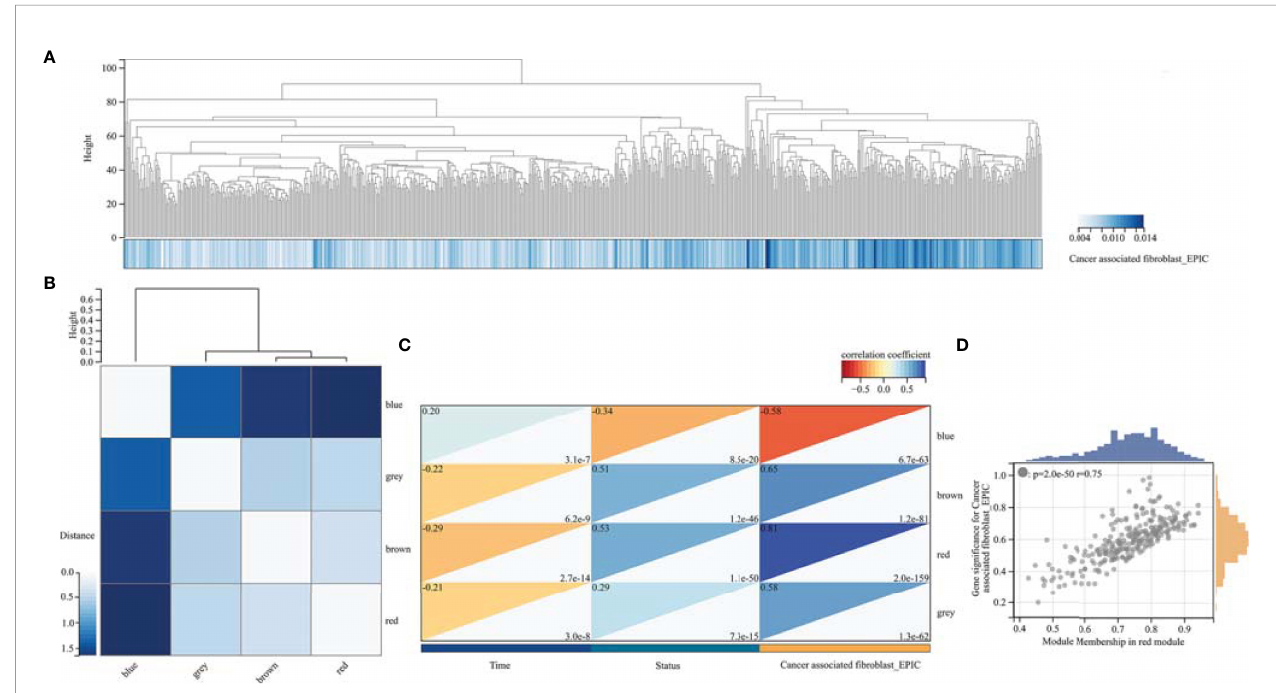
FIGURE 4 | Weighted correlation network analysis. (A) Clustering of samples in TCGA GBMLGG cohort. (B) Cluster dendrogram of modules. (C) Module – trait relationships indicated that the red module was most related to TAF in fi ltration in glioma. (D) Scatter plot of correlation between GS and MM. GS, Gene signi fi cance; MM, Module